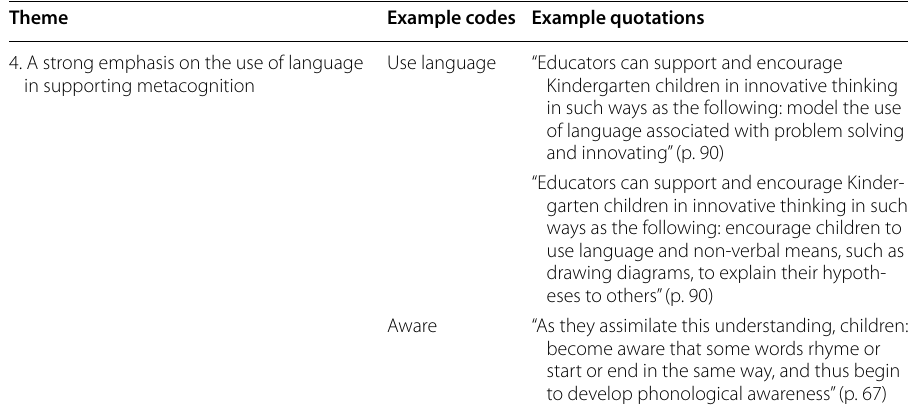
Table 5 Overview of Theme 4, example codes, and quotations